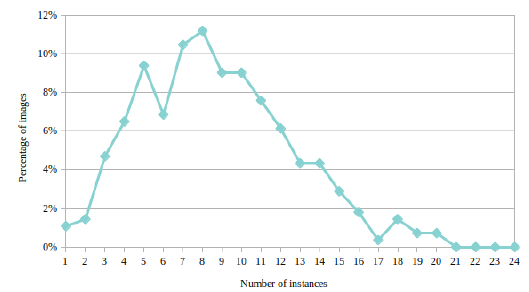
Figure 4. Histogram of the number of annotation instances per image